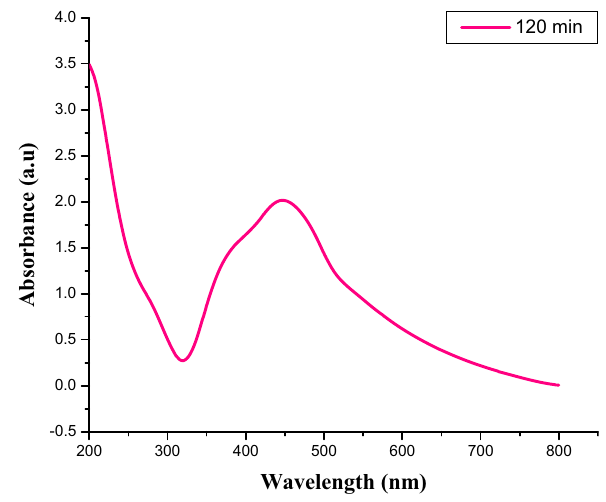
Figure 1: The UV - Vis absorbance spectra of synthesized Cs - AgNPs.